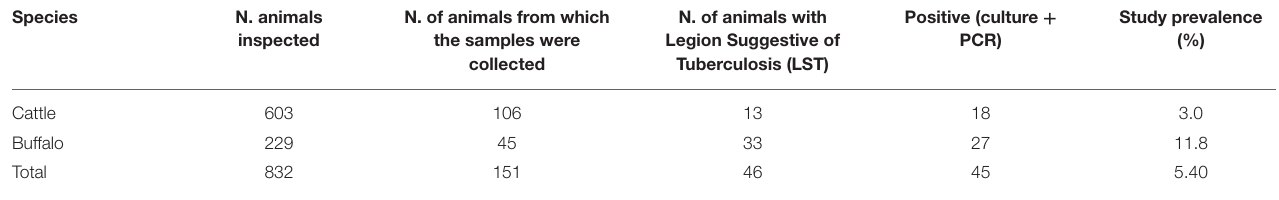
TABLE 4 | M. bovis prevalence by species in Amazonas State, Brazil. Species N. animals